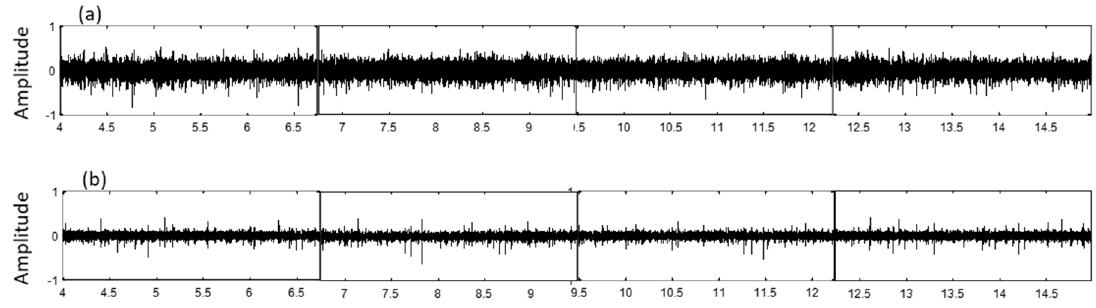
Figure 8. Segments of the audio signal in time domain corresponding to the gear set in ( a ) good condition and ( b ) with fault.